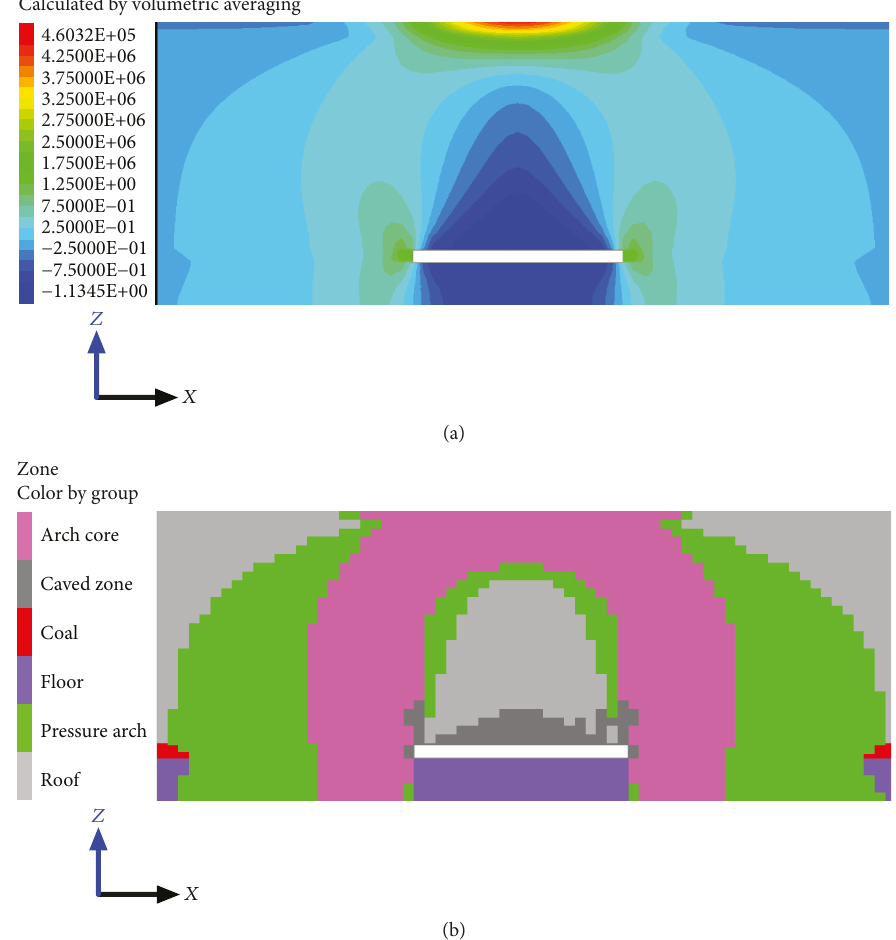
Figure 10: The arching index and pressure arch in the surrounding rock. (a) The arching index distribution. (b) The pressure arch in the surrounding rock.